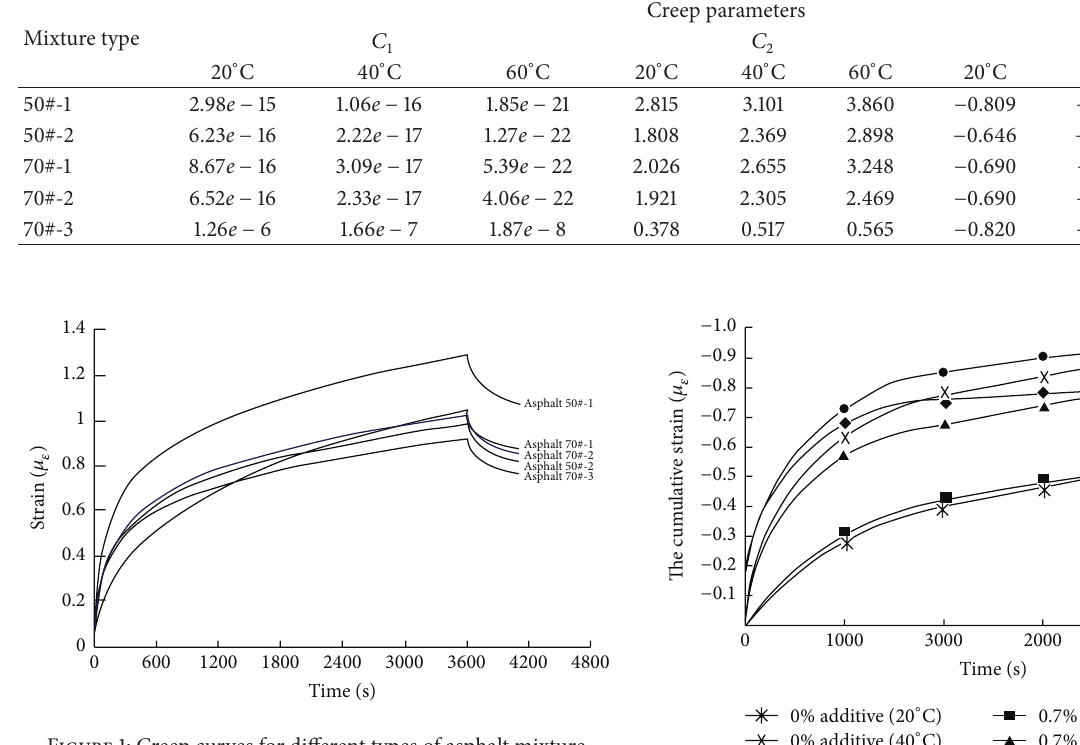
Figure 1: Creep curves for different types of asphalt mixture. remains deformed permanently because of its irreversibility.